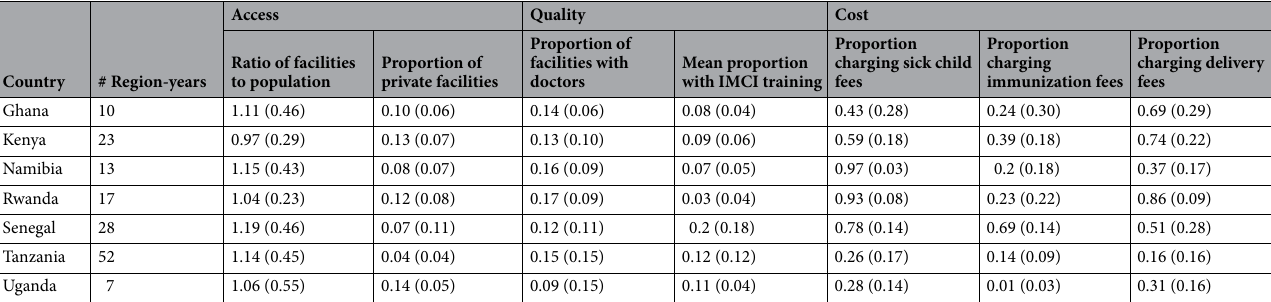
Table 2. Country-level health systems characteristics. Mean (SD) The ratio of facilities to population serves as a proxy measure for physical access and describe the concentration of facilities relative to the concentration of population in that region. The proportion of private facilities describes the relative availability of private healthcare. The proportion of facilities with a doctor, the mean number of staff, and the proportion of staff per facility trained in Integrated management of childhood illnesses (IMCI) represent the capacity to deliver quality services. Finally, the proportion of facilities charging fees for acute sick child visits, routine immunization (scheduled prevention visits) and normal delivery represent the out-of-pocket cost of